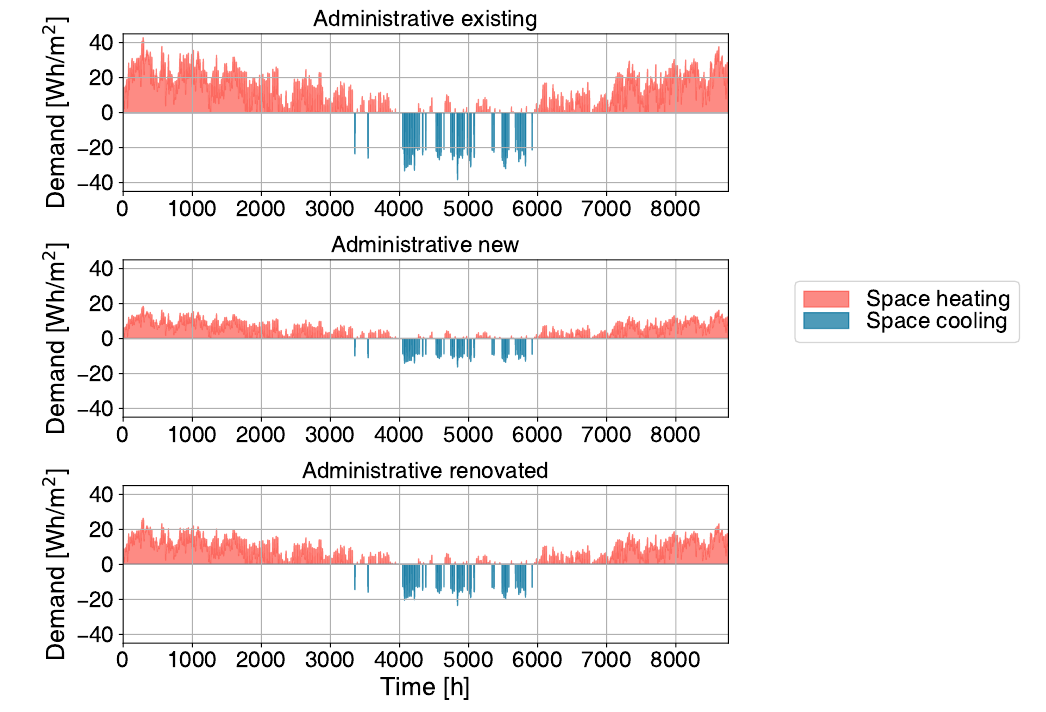
Figure 8. Hourly specific energy service demand of administrative